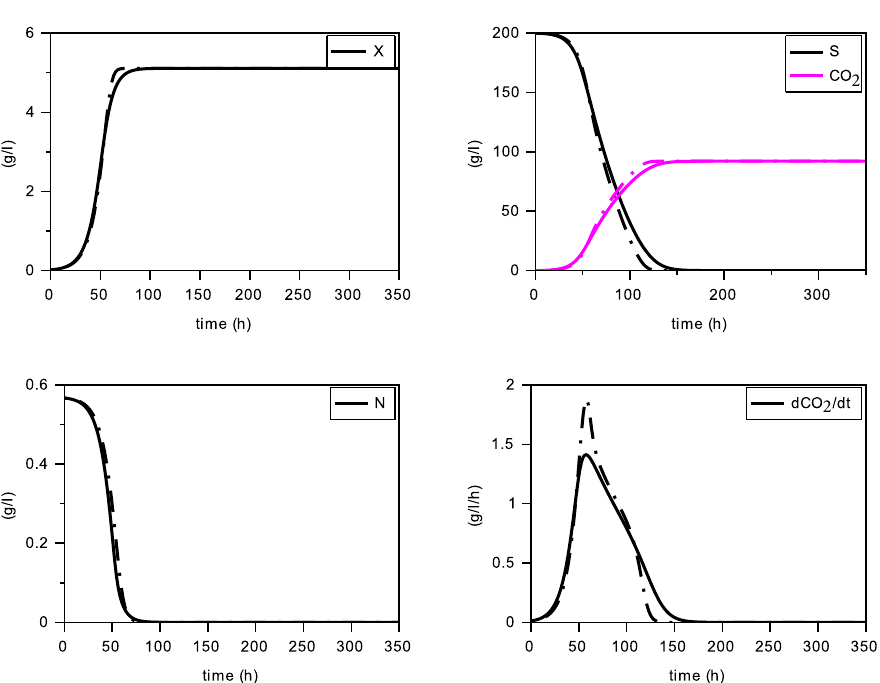
Figure 6. Comparison with the model with transporters (in dashed) for N ( 0 ) = 0.567 g · L − 1 (constant temperature of 24 ◦